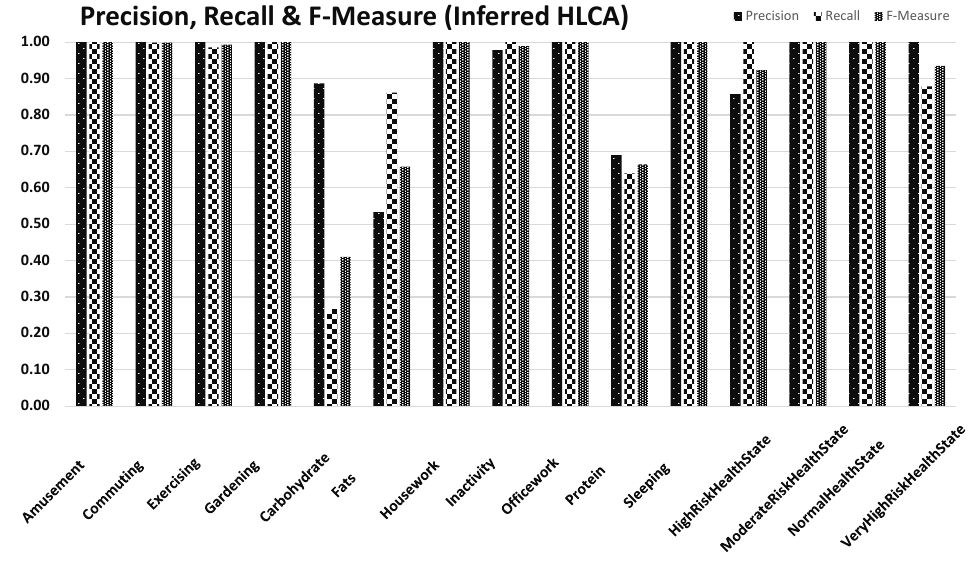
Figure 14. Precision, Recall and F-Measure for recognized PA-HLCs, N-HLCs and